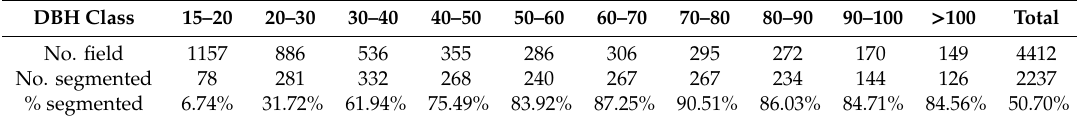
Table 1. Number of trees in ten DBH classes in the 25 ha ZFDP and the corresponding number of trees segmented within each DBH class.